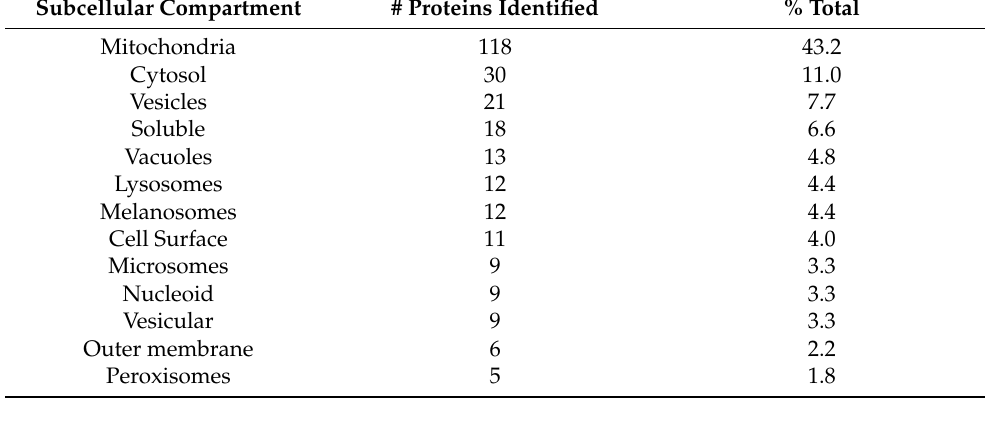
Table 3. Distribution of proteins in subcellular compartments from culture media of human proximal tubular (hPT) cells incubated with S -(1,2-dichlorovinyl)-L-cysteine (DCVC). Data are shown for primary cultures of hPT cells incubated with 250 µ M DCVC for 24 h. A portion of each sample of extracellular medium was reduced with dithiothreitol, alkylated with iodoacetamide, and digested overnight with trypsin. Samples were then labeled with a unique isobaric TMP TM reporter tag. Multiplexed samples were analyzed using a Q Exactive Orbitrap mass spectrometer (Thermo Fisher Scientific). Abundant species were fragmented in high-energy collision dissociation mode. Data were analyzed using Proteome Discover version 1.4.0.288 (Thermo) and Scaffold Q+ version 4.1.1 (Proteome Software), which incorporate the Sequest, X! Tandem, and ProteinProphet algorithms. The SwissProt_2013_04 database with 20,253 entries was used.